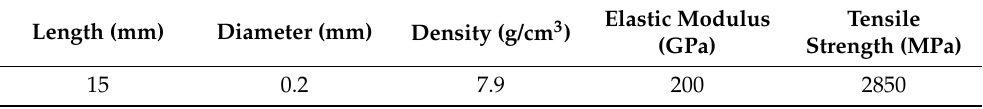
Table 2. Physical properties of steel